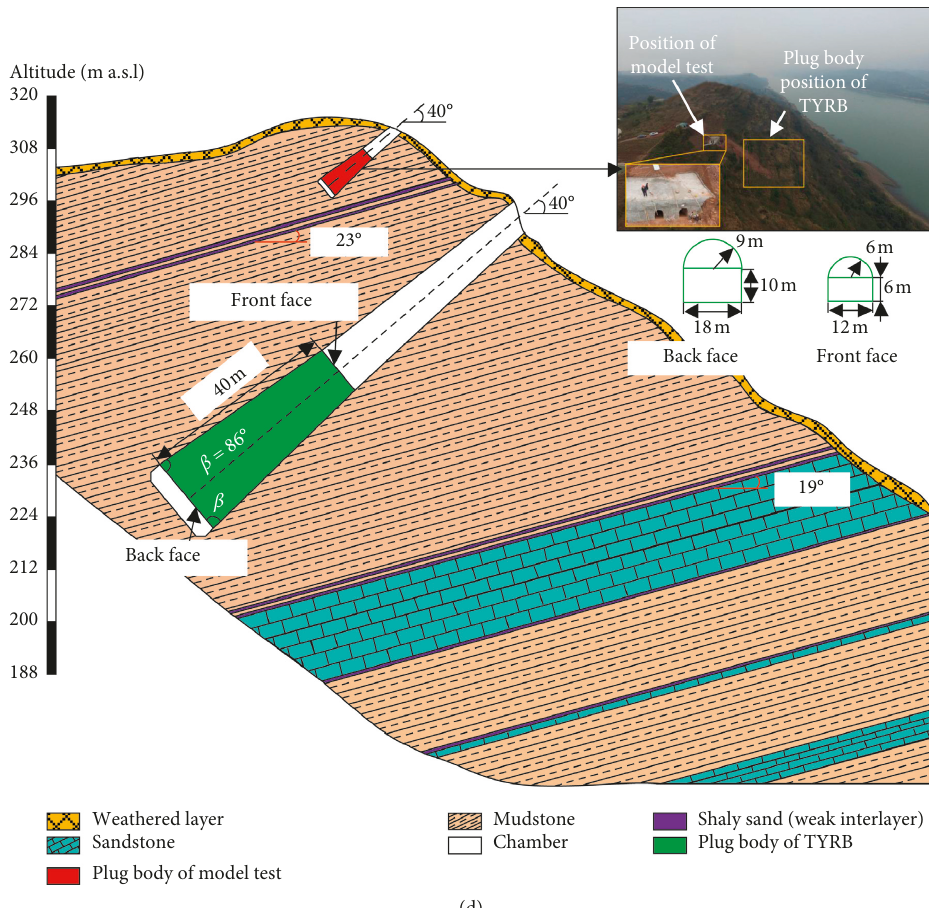
Figure 12: (a) Schematic of field model tests M1 and M2, (b) A-A profile, (c) stratum information and location relationship of the plug body between the model test and the JYRB, and (d) stratum information and location relationship of the plug body between the model test and the